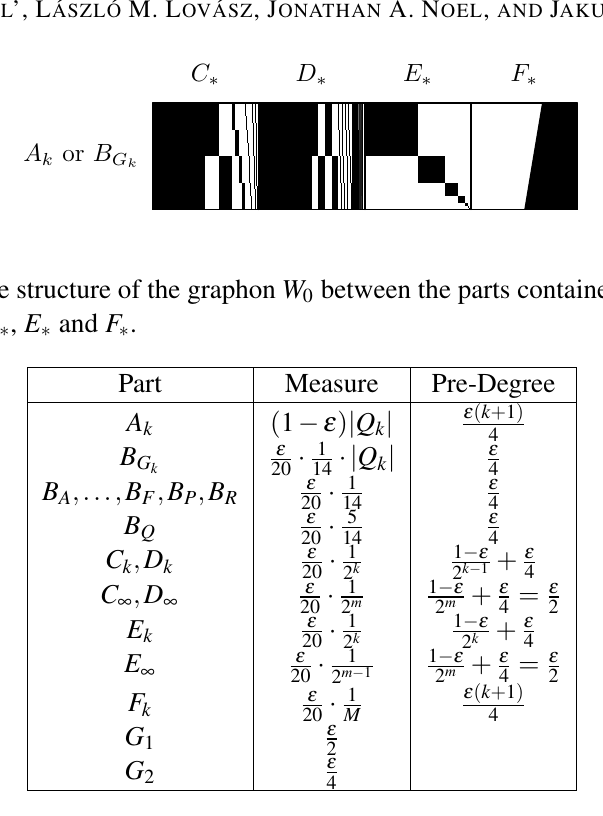
Table 2: The sizes and the pre-degrees of the parts of the graphon W 0